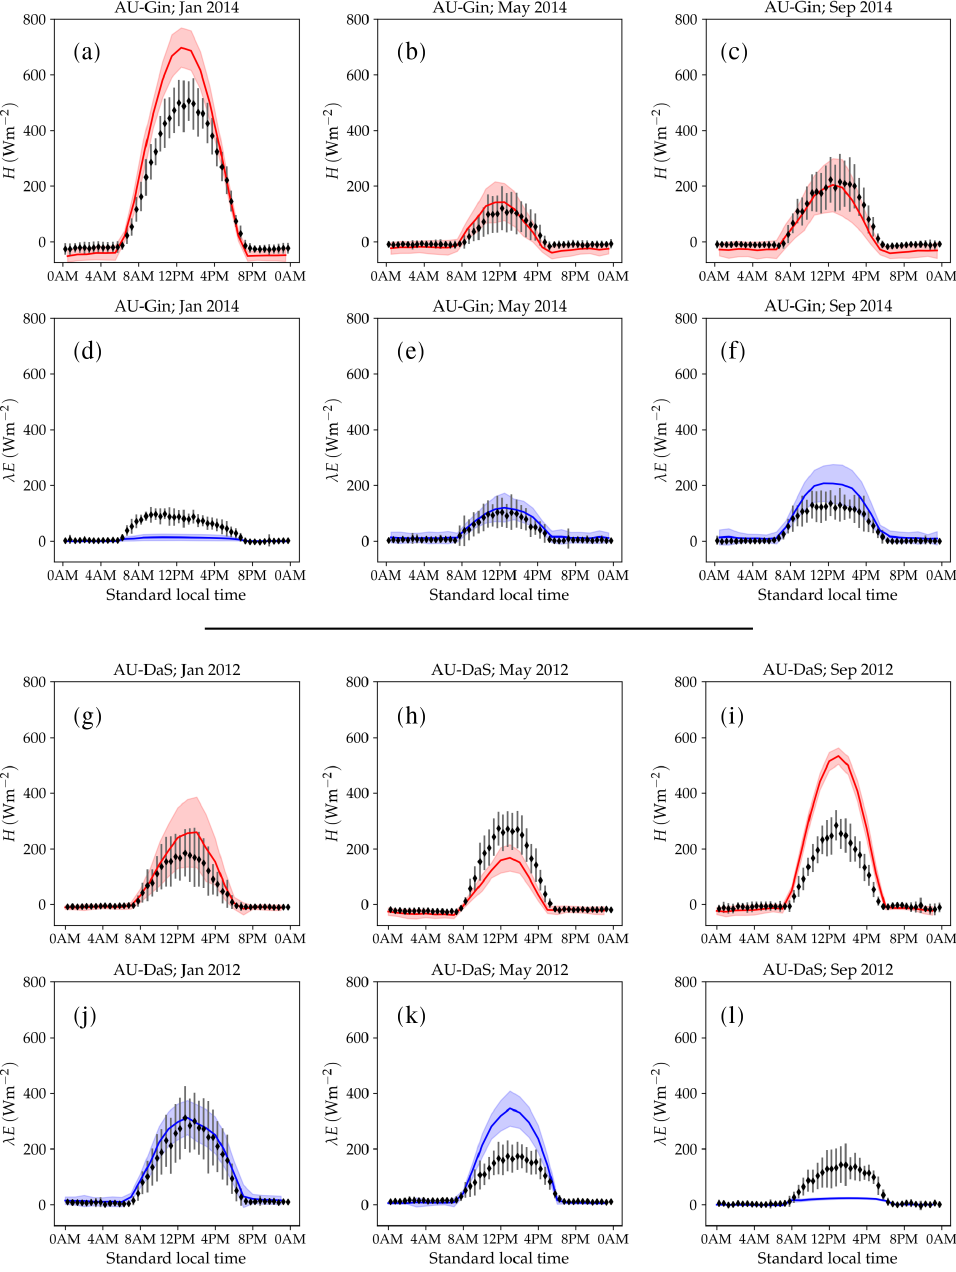
Figure 11. Monthly-averaged diurnal cycle of sensible and latent heat flux at the AU-DaP ( panels a–f) and AU-DaS ( panels g–l) sites in selected months. The red and blue lines represent simulated sensible and latent heat fluxes, respectively. The shaded areas around each curve delimit 1 standard deviation above and below it. The symbols represent monthly-averaged fluxes. The error bars indicate a ± 1 σ deviation from the observed